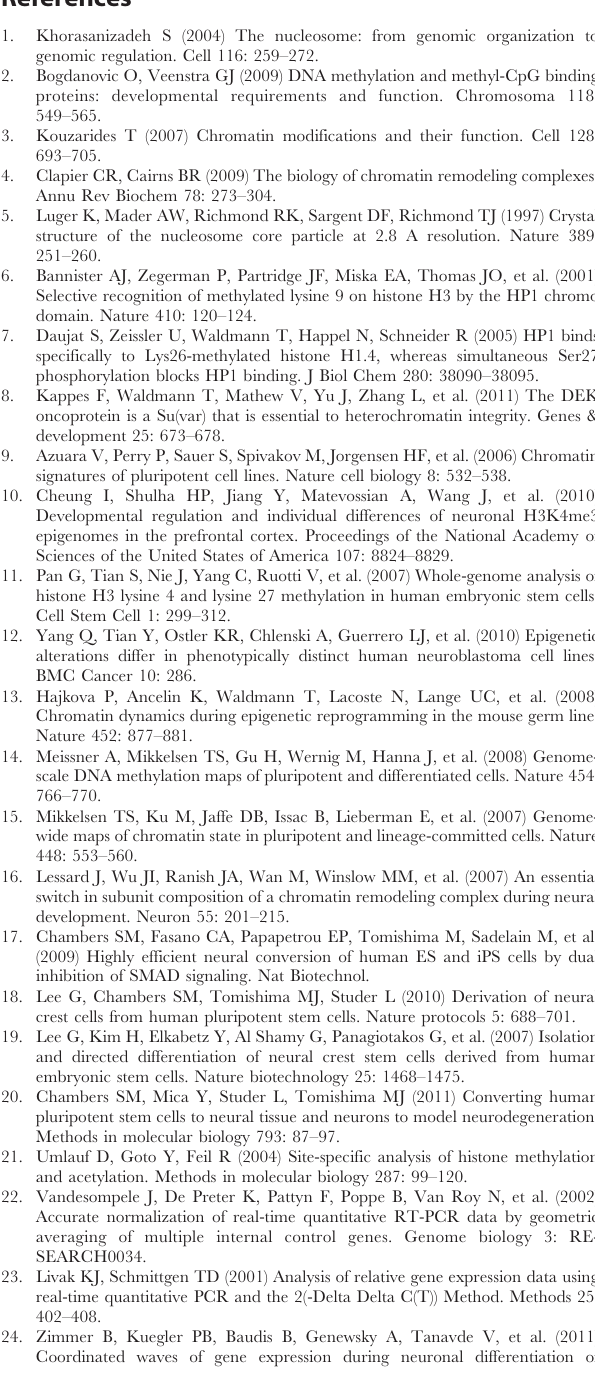
Fold expression values obtained from microarray data are blotted on the y-axis, and fold expression levels obtained from qPCR are blotted on the x-axis. For both data sets, non- significant values were set to 0. n: amount of genes in the different groups.